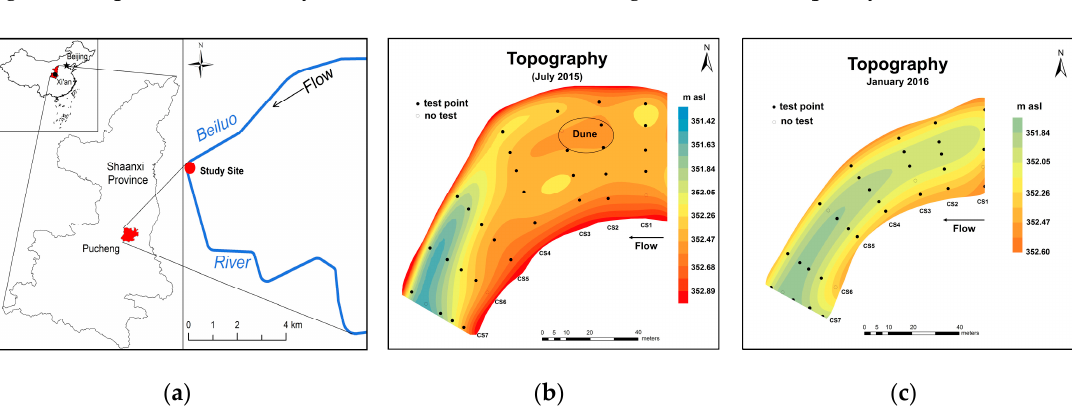
Figure 1. ( a ) Location of the study site within the Beiluo River; ( b ) streambed topography with test points along the channel bends in July 2015; and ( c ) streambed topography with test points along the channel bends in January 2016.